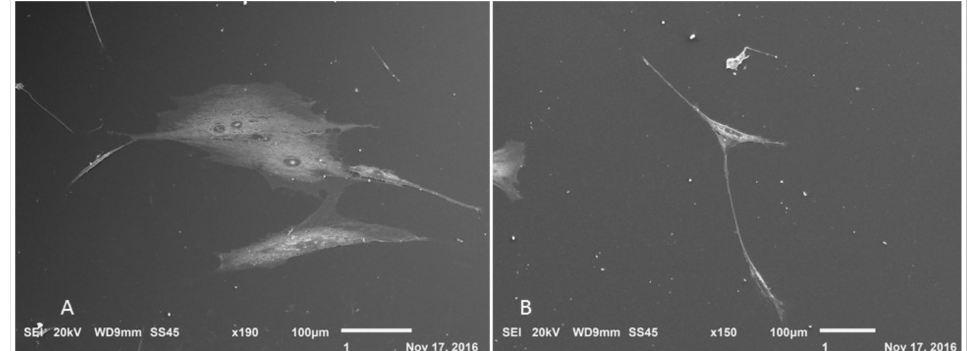
Figure 13. Scanning electron microscopy of cholinergic differentiation. ( A ) Undifferentiated control; ( B ) cell with neural characteristics (Jeol JFM—6010, LA).